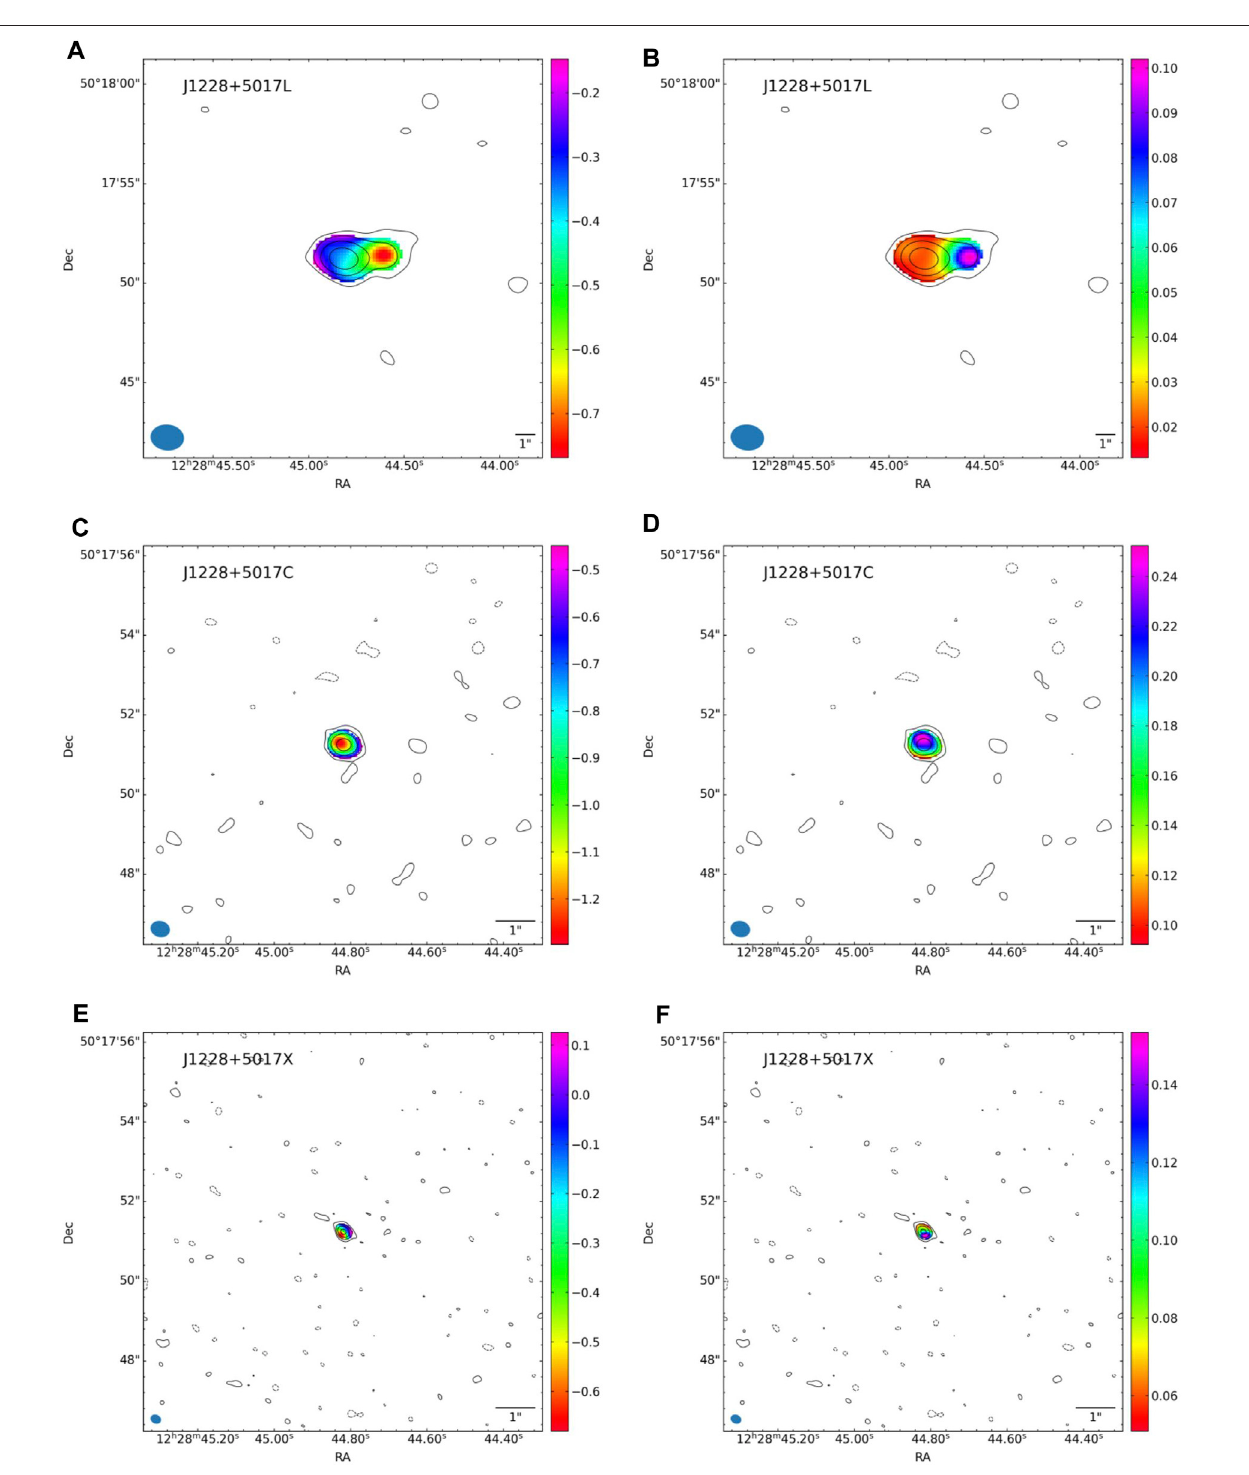
FIGURE 2 | (A) 1.6 GHz α map, rms (cid:1) 20 µ Jy beam − 1 , beam size 9.56 × 7.41 kpc; (B) 1.6 GHz Δ α map; (C) 5.2 GHz α map, rms (cid:1) 7.5 µ Jy beam − 1 , beam size 2.83 × 2.31 kpc; (D) 5.2 GHz Δ α map; (E) 9.0 GHz α map,rms (cid:1) 6.5 µ Jybeam − 1 ,beamsize1.58 × 1.19 kpc (F) 9.0 GHz Δ α map.Contourlevelsat − 3,3 × 2 n , n ∈ [0,3] in all fi gures. The scale is 5.657 kpc/arcsec.